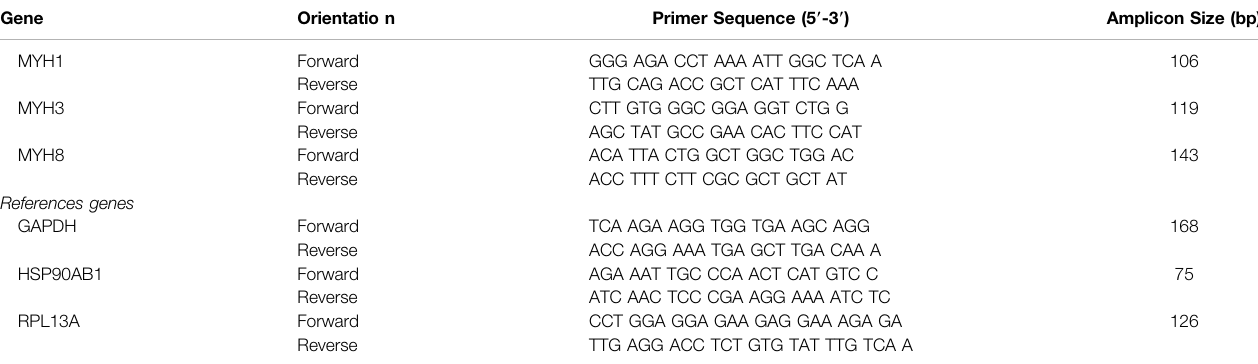
TABLE 1 | List of the primers used for RT-qPCR analysis. Gene Orientatio